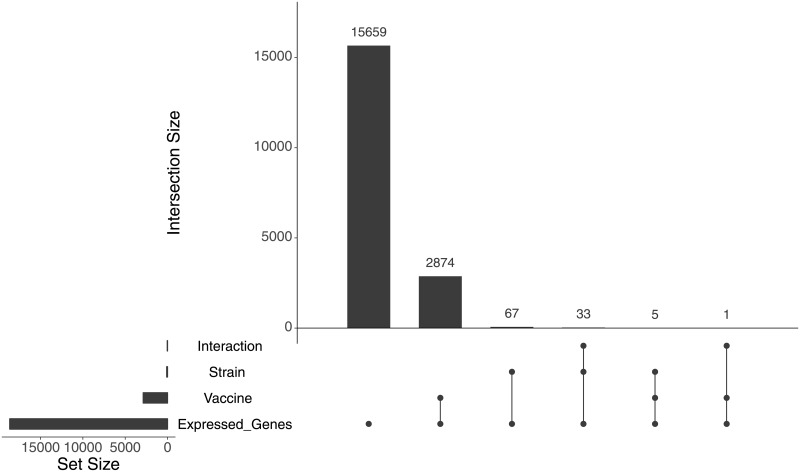
UpSet plot showing overlapping of genes identified by each of the different analyses.The bars show the overlap between the indicated motifs below: Expressed_Genes (all genes expressed in head kidney), Vaccine (DEGs in vaccinated fish), Strain (only vaccinated fish with strain as covariate) and Interaction (interaction of strain and diet in vaccinated fish only).